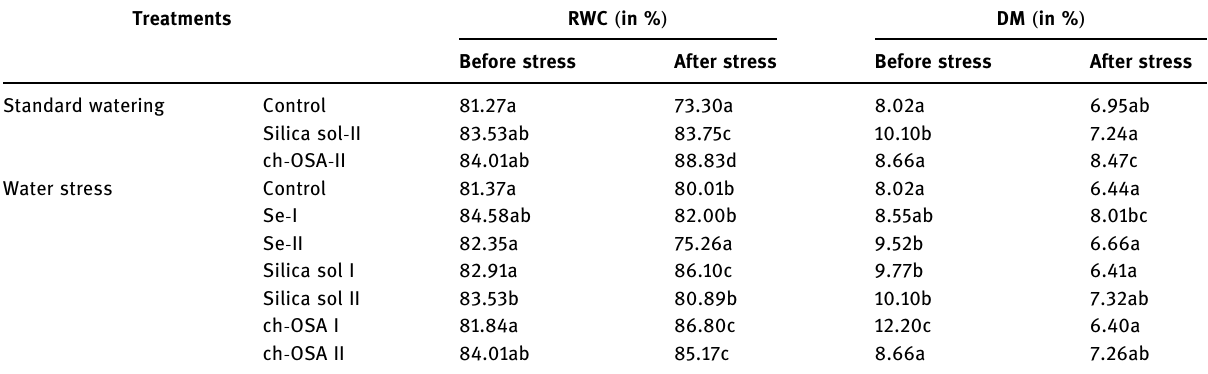
Table 2: The in fl uence of the factors under study on the relative water content ( RWC ) and dry matter content ( DM ) in Tagetes patula L. “ Pascal ”’ leaves